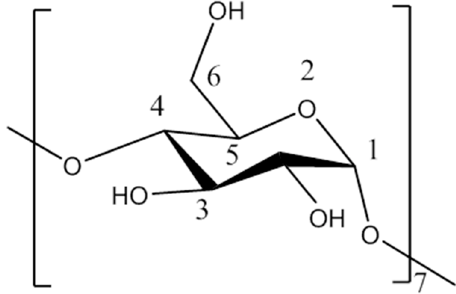
Figure 2. Schematic structure of β -cyclodextrin ( β -CD).